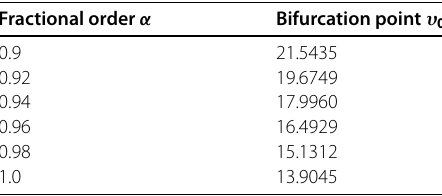
Figure 1, and when υ = 21 > υ 0 = 19.6749, there occurs a Hopf bifurcation at the positive equilibrium point u ∗ as demonstrated in Figure 2. Table 1. In order to make a comparison with the uncontrolled fractional-order model (2.7), we discuss the controlled model (4.2) with the parameters α = 0.92, m = 0.2. When we choose the control parameters k p = –0.05, k d = 0.5, from (4.7) we can obtain υ c can be seen that the stable region has been enlarged and the critical value υ c increased to a larger value than that of the uncontrolled model. This indicates that